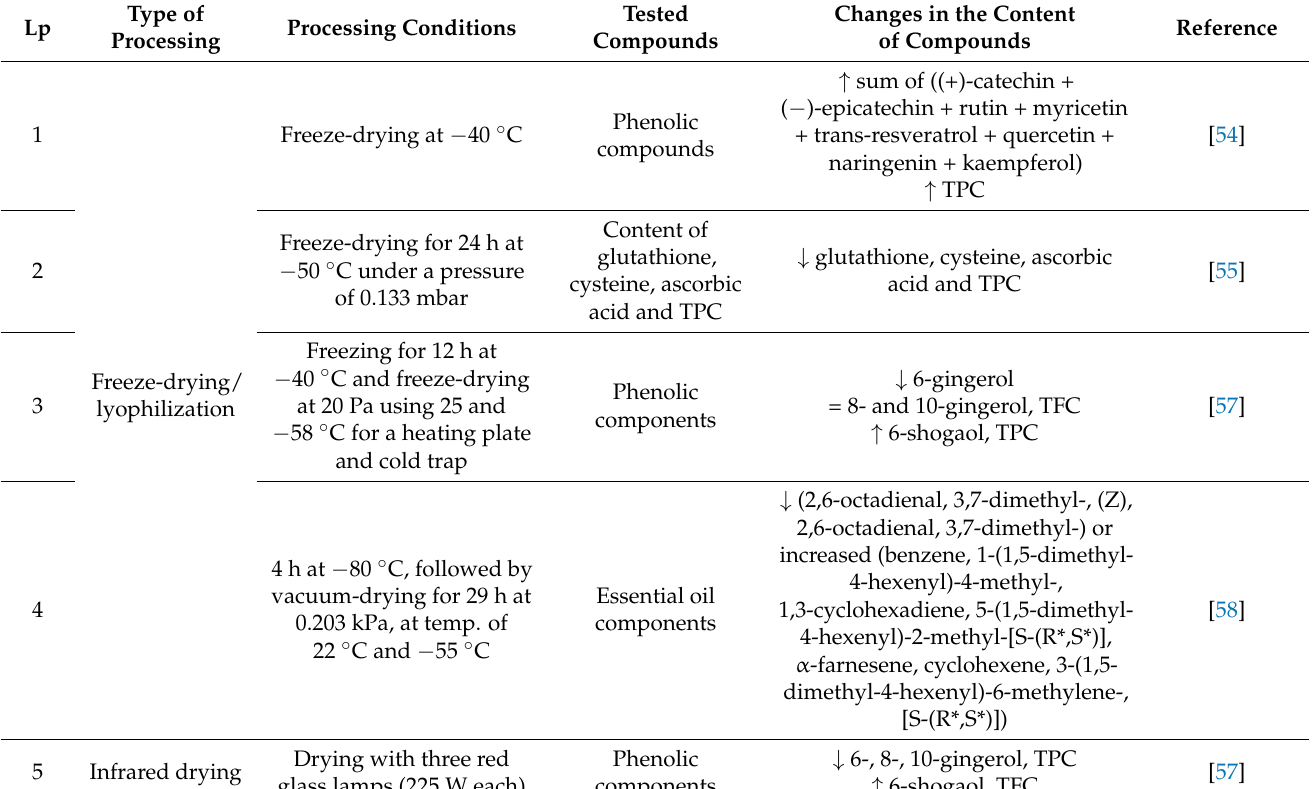
Table 2. Effect of lyophilization and infrared drying (unconventional methods) on the content of secondary metabolites in